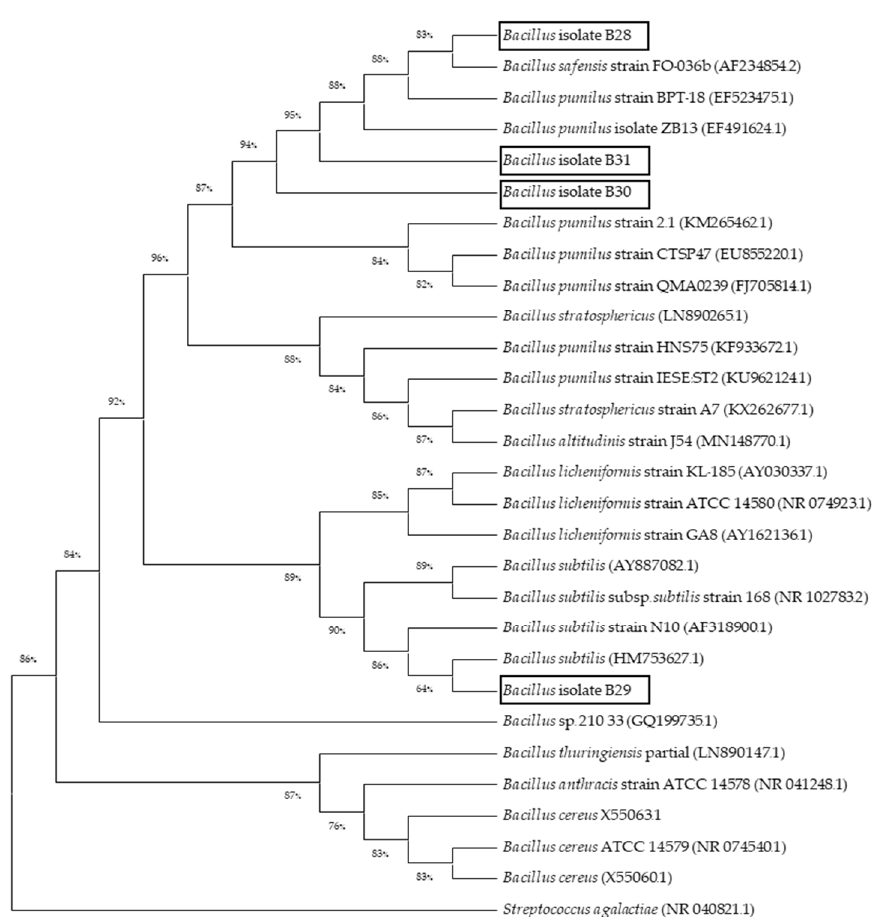
Figure 2. A phylogenetic tree analysis of 16s rRNA gene sequence of four Bacillus isolated from Nile tilapia’s intestine and other known Bacillus species from GenBank database. The tree was constructed using 1000 bootstrap replications with MEGA X using maximum-likelihood phylogeny method with MUSCLE alignment [35,36]. A discrete Gamma distribution was used to model evolutionary rate differences among sites. The percentages of replicate trees in which the associated taxa clustered together in the bootstrap test (1000 replicates) are shown above the branches. The GenBank accession numbers are provided in brackets.